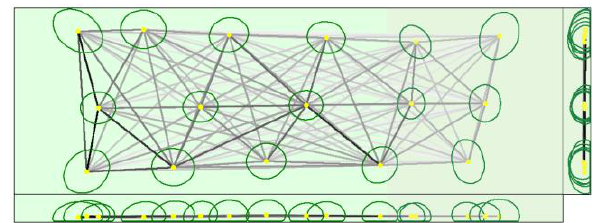
Figure 4. Such graphic representation with error ellipses is similar to the typical way to visualization of geodetic networks. The shape (circular or elongated) and size of ellipses provides an immediate indication of the quality of image orientation.